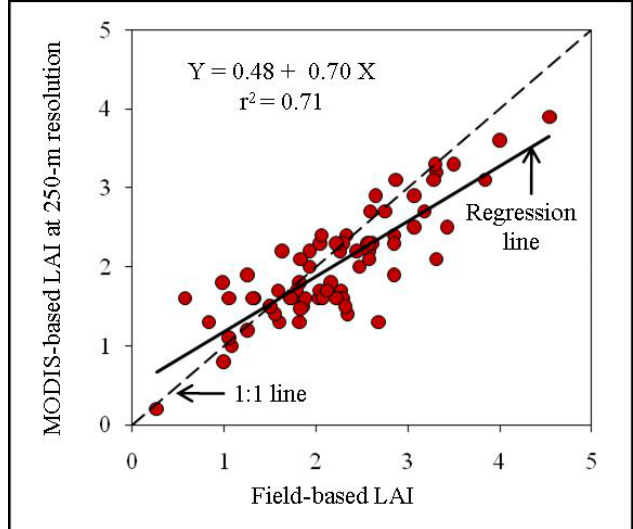
Figure 8. Comparison of 72 field-based measurements with their corresponding MODIS-based LAI for June 2009 at 250-m resolution; F-statistic = 171.23 and p -value <